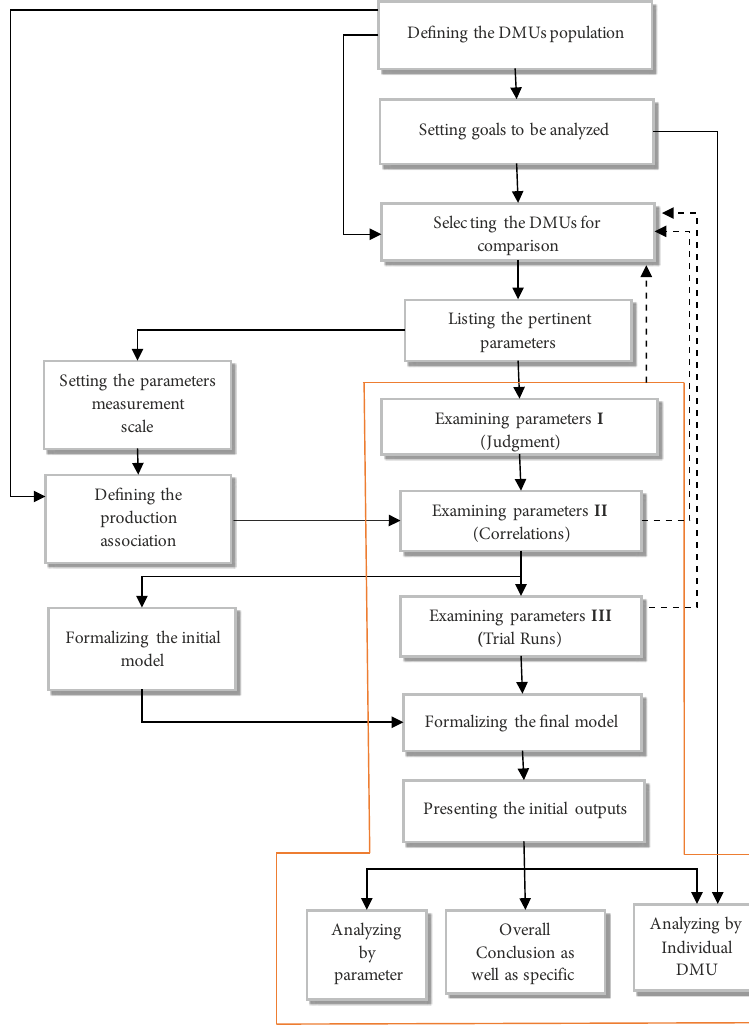
Figure 1. DEA process (Lai et al.,